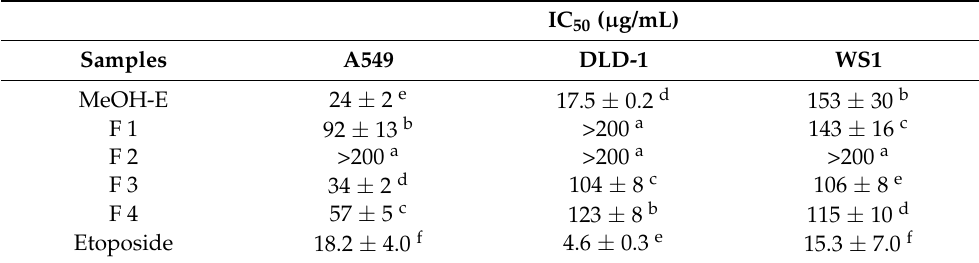
Table 4. Cytotoxic activity of R. raetam methanolic extract (MeOH-E) and the subsequent fractions (F1, F2, F3, F4) against tumor (A549, DLD-1) and healthy (WS 1) cell lines. IC 50 ( µ g/mL) Samples A549 DLD-1